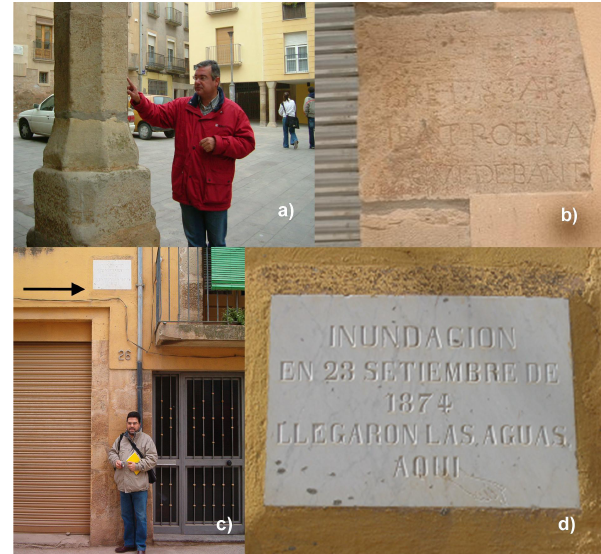
Fig. 5. Three of the five limnimarks found: (a) carving on a column at Sant Antoni Square marking the 1644 flood’s maximum water height (observation 2 in Fig. 6), (b) sandstone plaque at Sant Agust´ı Street corresponding to the 1783 flood (observation 3 in Fig. 6), (c) marble plaque (marked by an arrow) at Sant Agust´ı Street corre- sponding to the 1874 flood (observation 5a in Fig. 6) and (d) detail of that